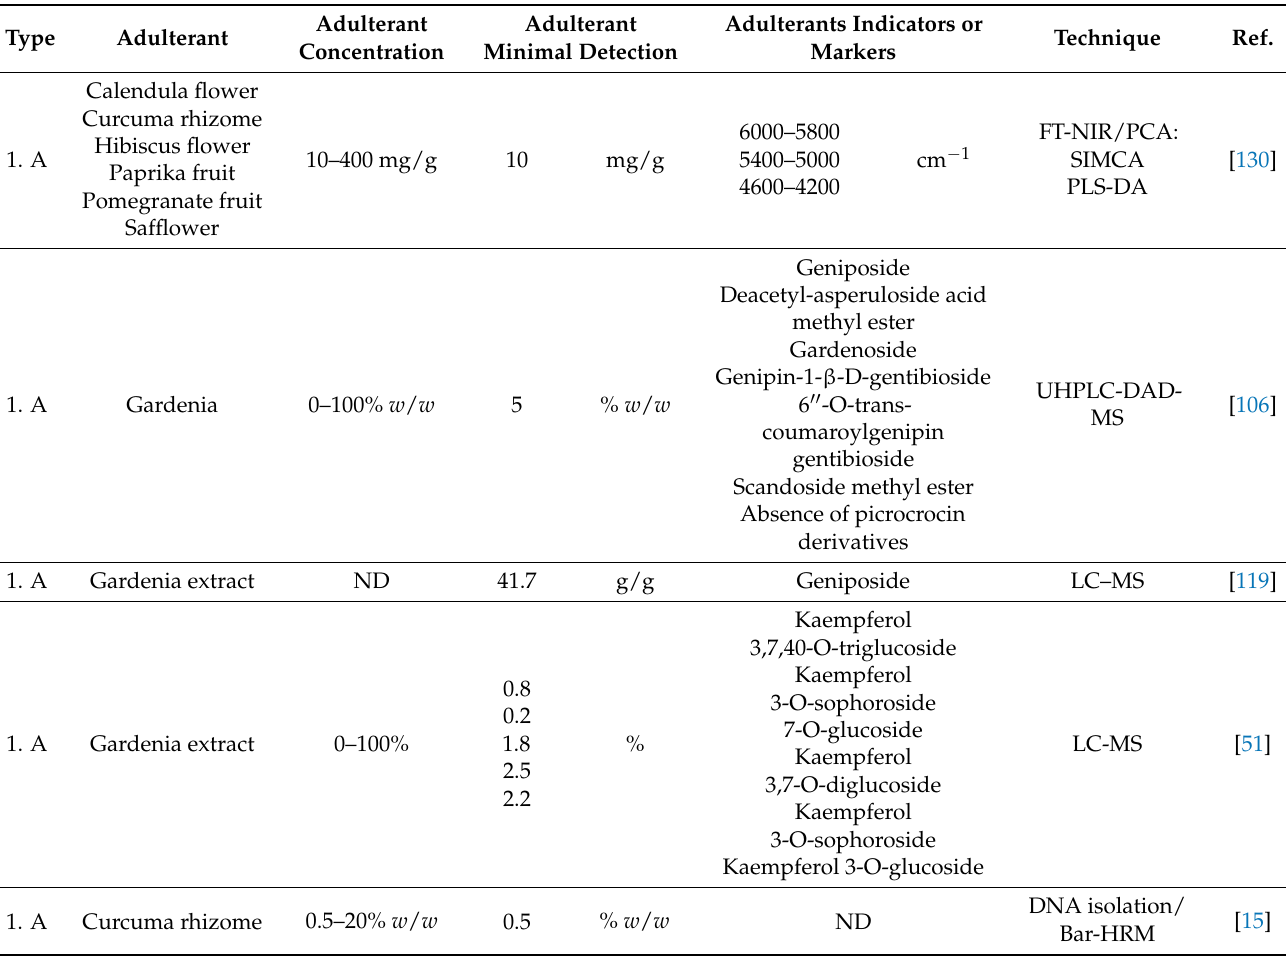
Table 2. Different techniques for saffron adulterant